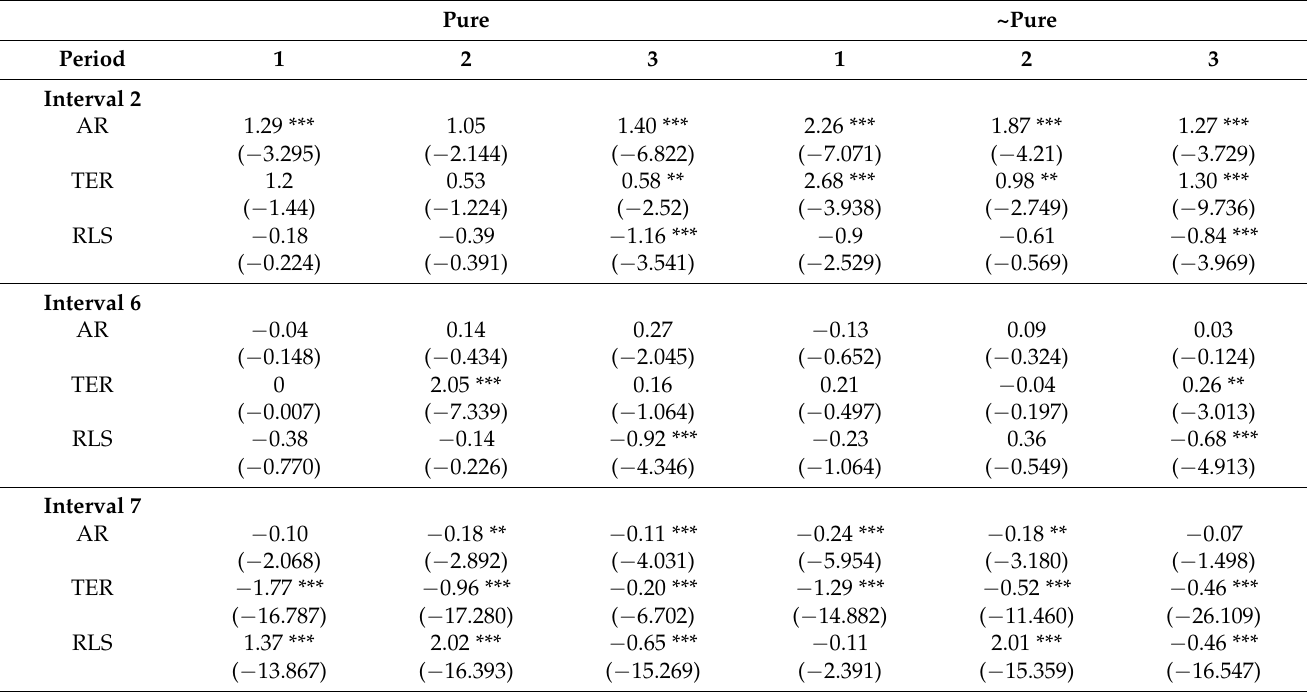
Table 3. Abnormal returns (%) and liquidity measures (%) by study period control variable: purity of announcement. Pure